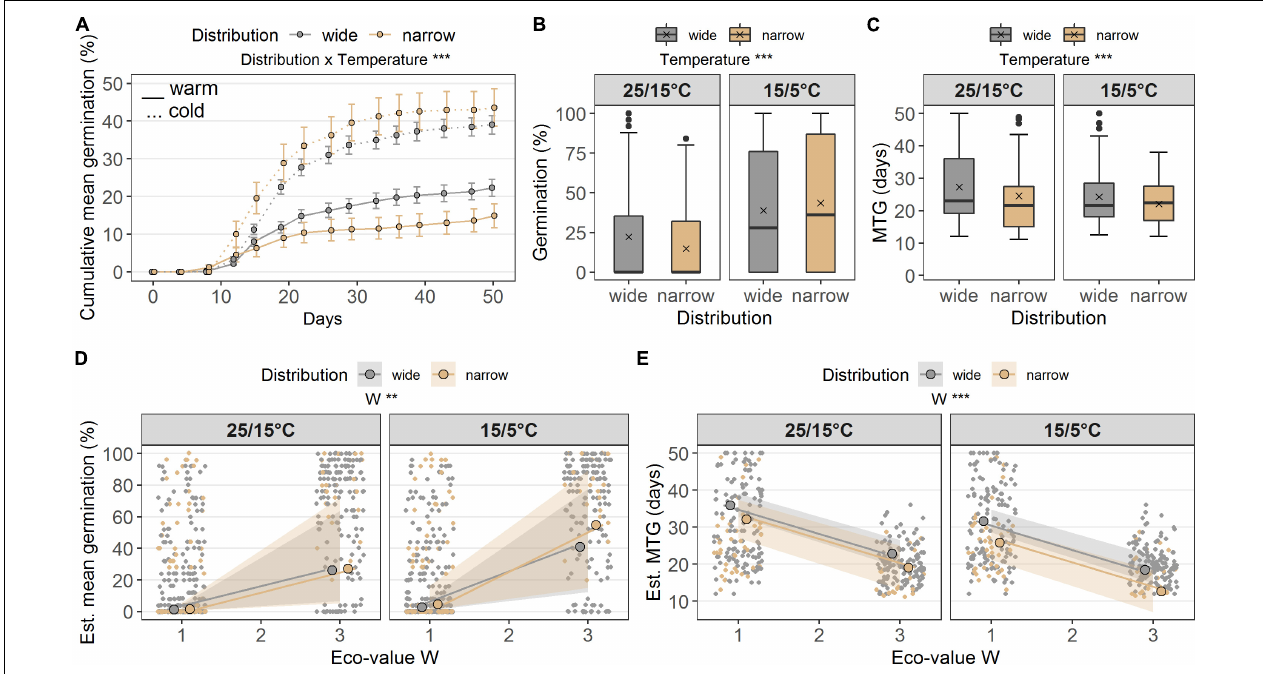
FIGURE 2 | (A) Cumulative germination (%) in the laboratory at two temperature regimes (warm 25/15 ◦ C, cold15/5 ◦ C), grouped according to distribution ranges (wide, narrow). Points denote the cumulative mean on each day of observation, error bars denote ± standard errors. Boxes in (B) germination (%) and (C) MTG (days) illustrate the interquartile range with the median as line; whiskers illustrate the minimum and maximum; points denote outliers; x denotes the mean. Points without border in (D) germination (%) and (E) MTG denote the observed values colored according to the distribution range along the ecological indicator value W (alternate soil humidity); points with border denote the estimated means and colored ribbons denote confidence intervals from the models. Note different maxima on y -axis between panels. Stars denote significances at α = 0.01 (**) and α = 0.001 (***).